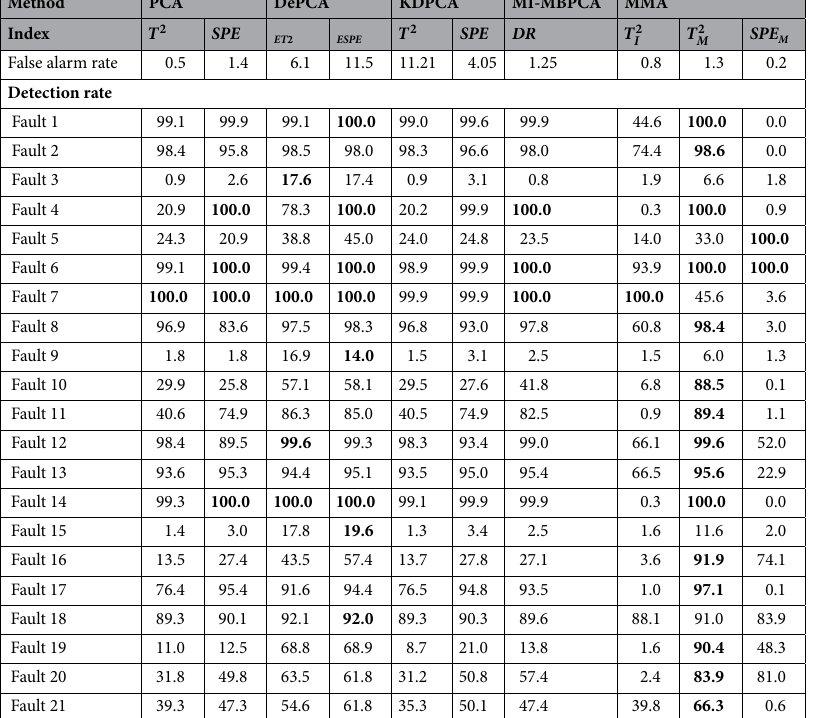
Table 4. False alarm rates (%) and detection rates (%) of the four fault detection